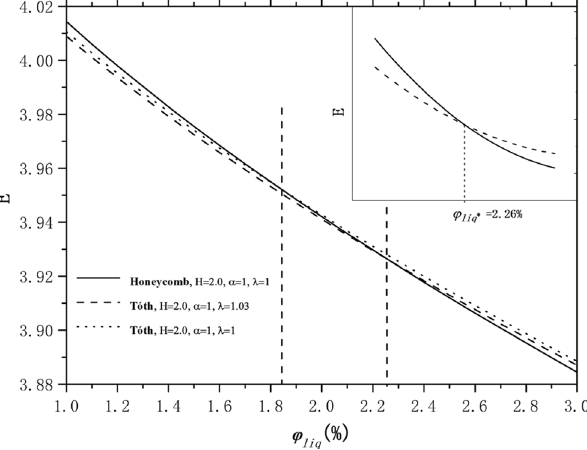
Figure 3. The dimensionless interfacial energy E of the honeycomb structure and the Tóth structure for λ = 1.03 and λ = 1, plotted as a function of liquid fraction ϕ = 2.0. The Tóth structure energies include liq when H λ = 1, since the external constraints might force λ to be 1. These diagrams show the honeycomb structure and Tóth structure (for λ = 1.03) crossover at about ϕ liq = 2.26%, denoted ϕ liq * . For ϕ liq below ϕ liq * , the Tóth structure has a lower energy. The energies are accurate to about six digits; the critical liquid fraction is probably accurate to at least two